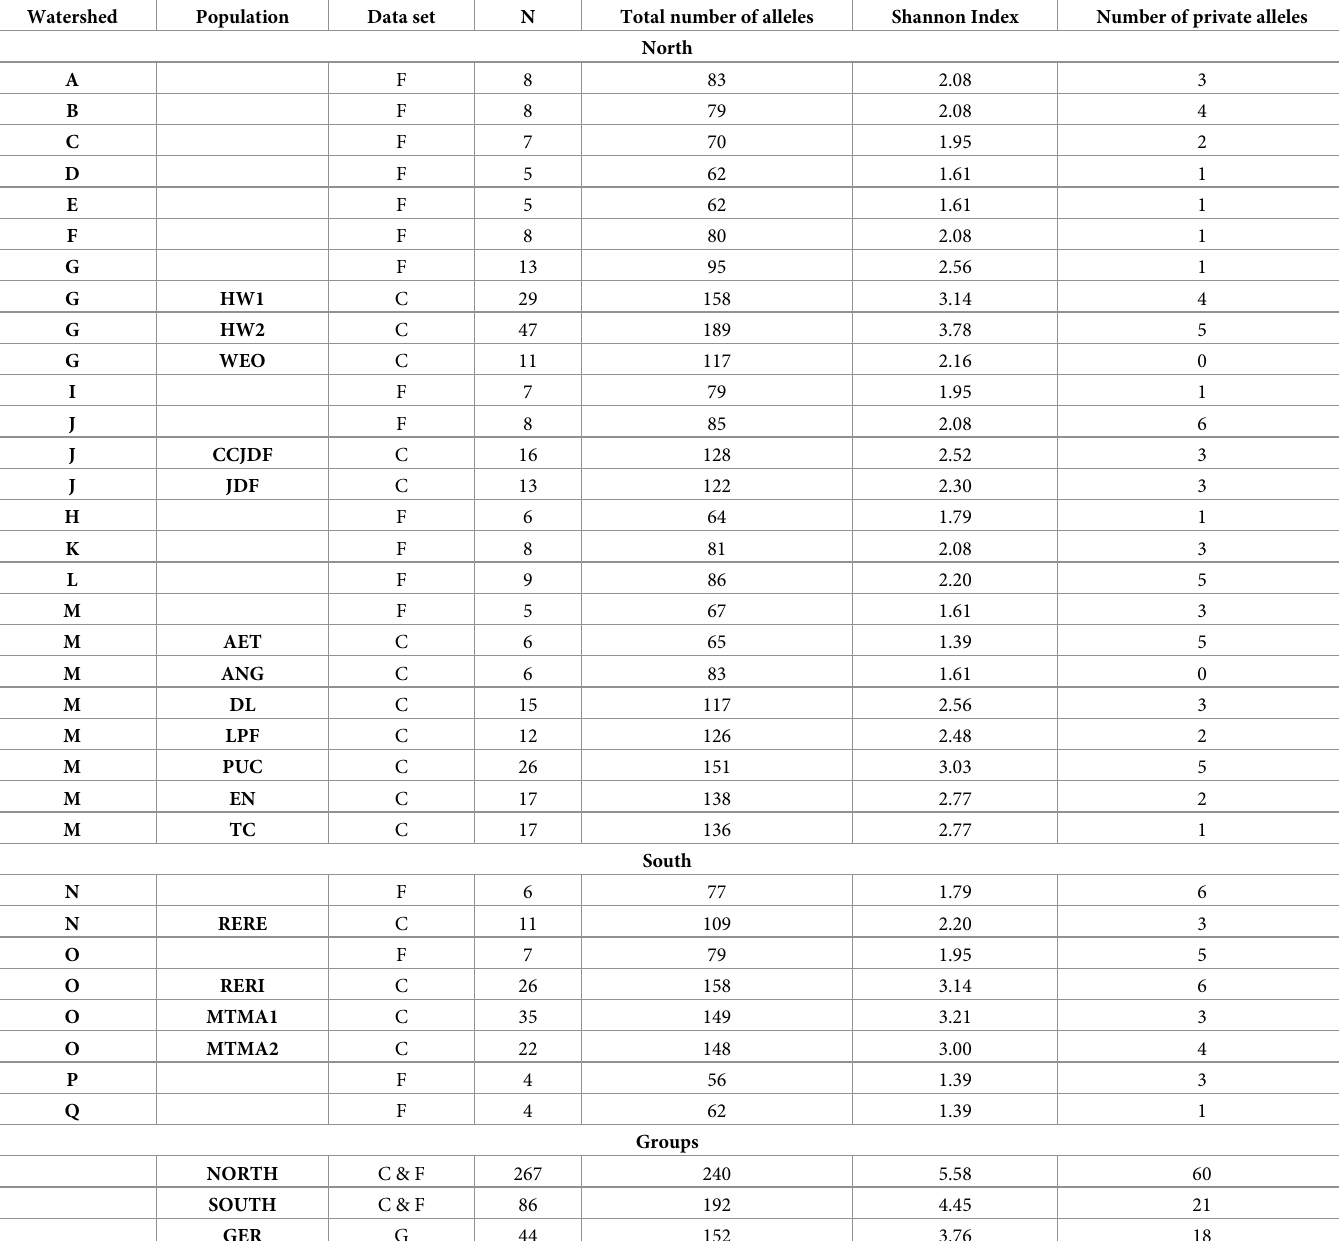
Table 1. Diversity measures for populations in Californian data set (C), 16 watersheds (A-Q) in French data set (F) and three groups consisting of the trees pooled from populations located above (NORTH) and below (SOUTH) San Francisco Bay in both C and F sets, and all German genotypes together (GER) based on 12 nuclear SSR